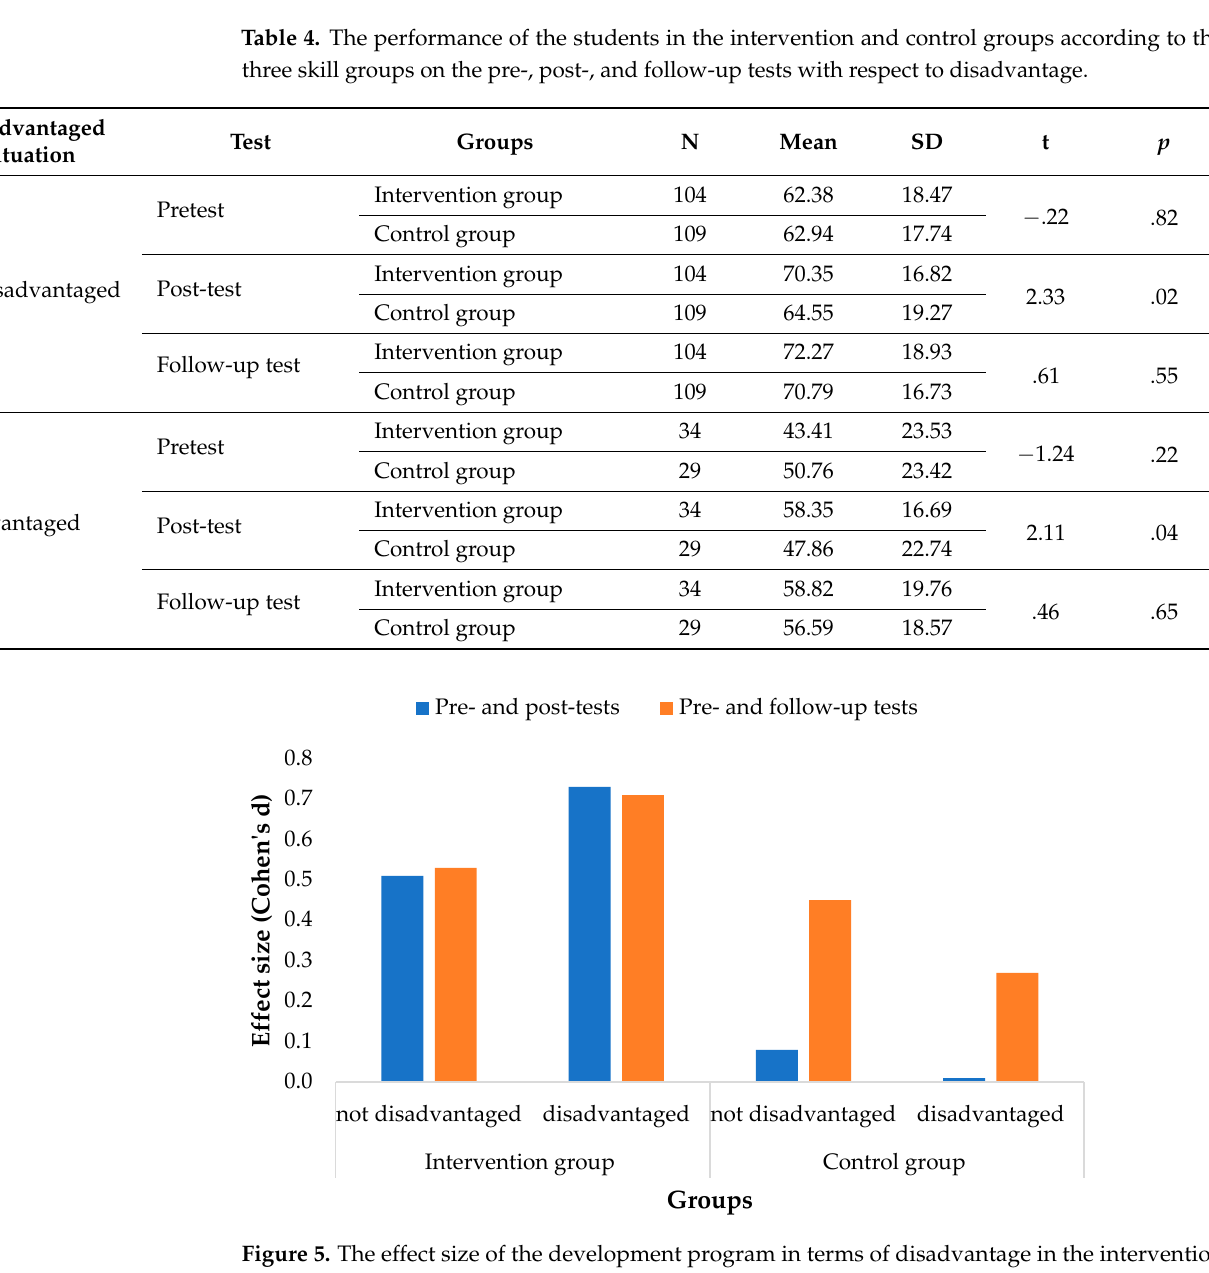
Figure 5. The effect size of the development program in terms of disadvantage in the intervention and control groups .